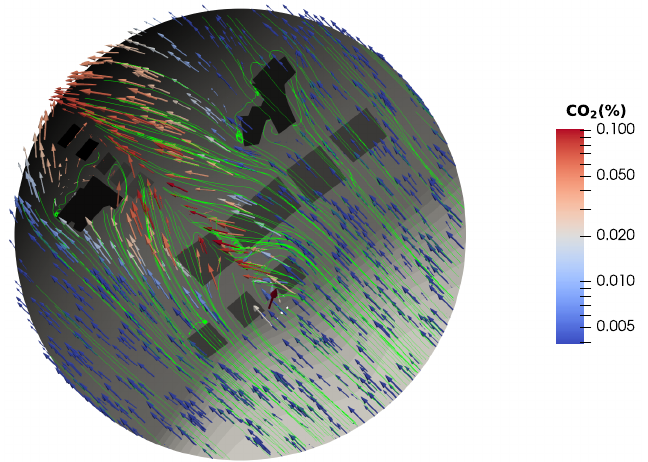
Figure 10. Air circulation at street level. The streamlines (green) represent the wind path around the buildings. The vectors give the wind speed and direction at each point. The colors of the vectors follow the CO 2 distribution. The wind blows in the north-west ( − 1,1, 0 ) direction. The chimney is 10 m high and the gas has 110 ◦ C at the exit of the plume. The ambient temperature is 10 ◦ C.